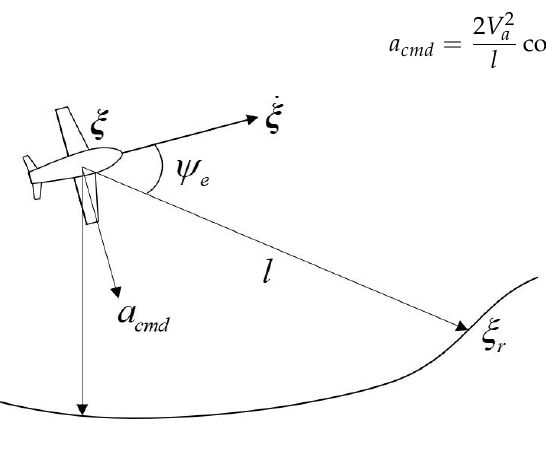
Figure 3. Nonlinear lateral control for the